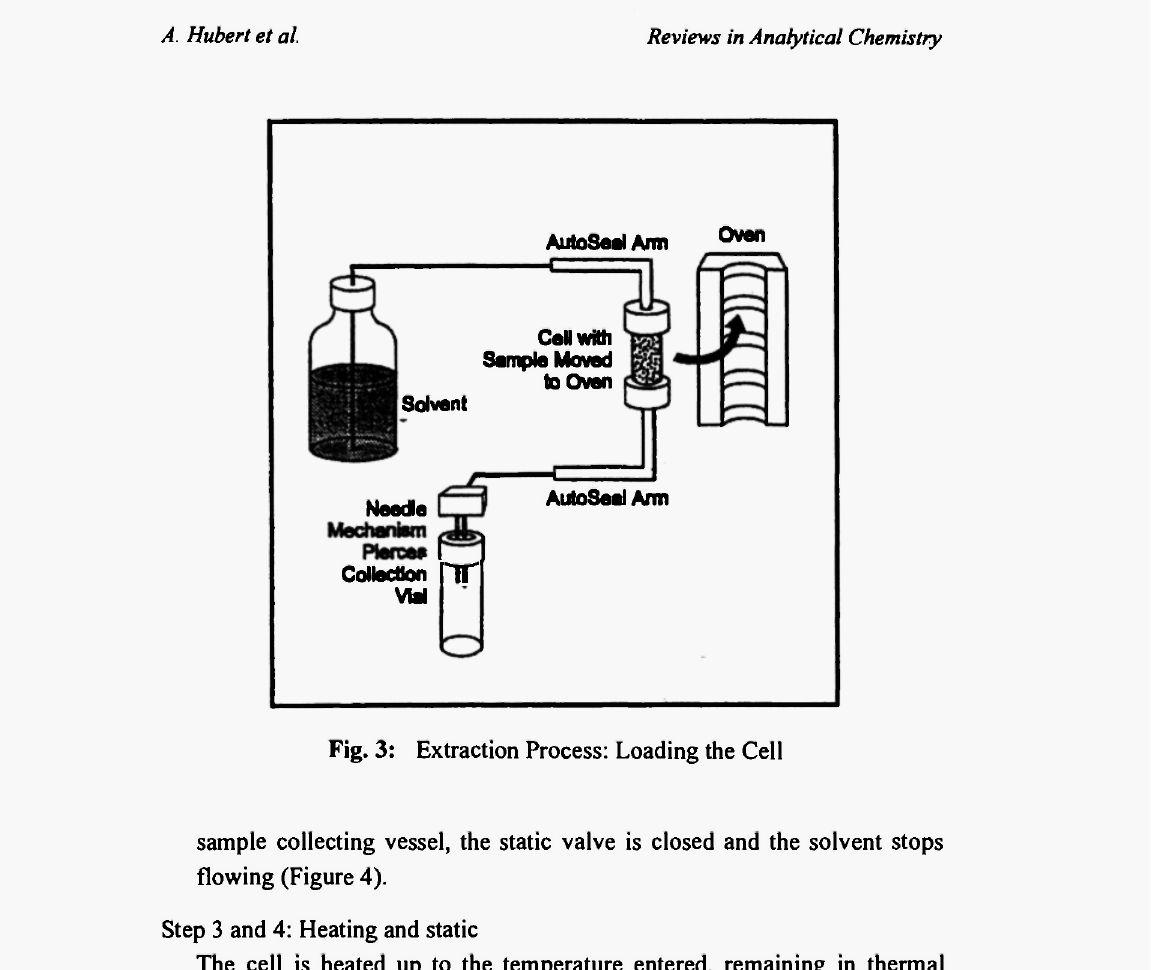
Fig. 3: Extraction Process: Loading the